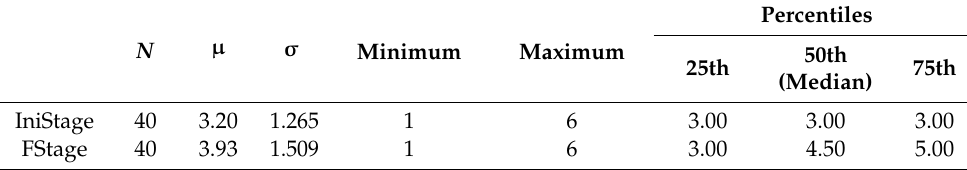
Table 6. Descriptive values of the initial and final behavior change stages of the TTM scale.